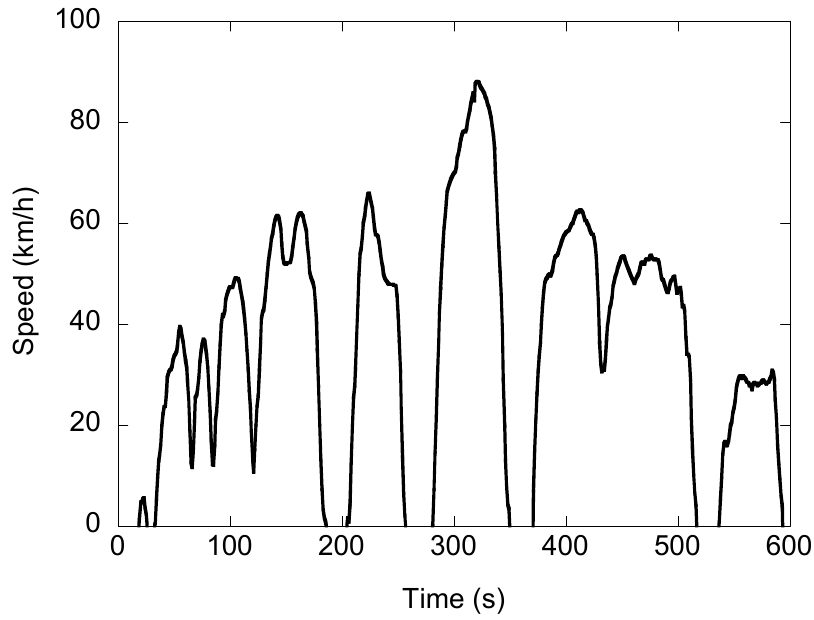
Figure 1. SC03 cycle speed